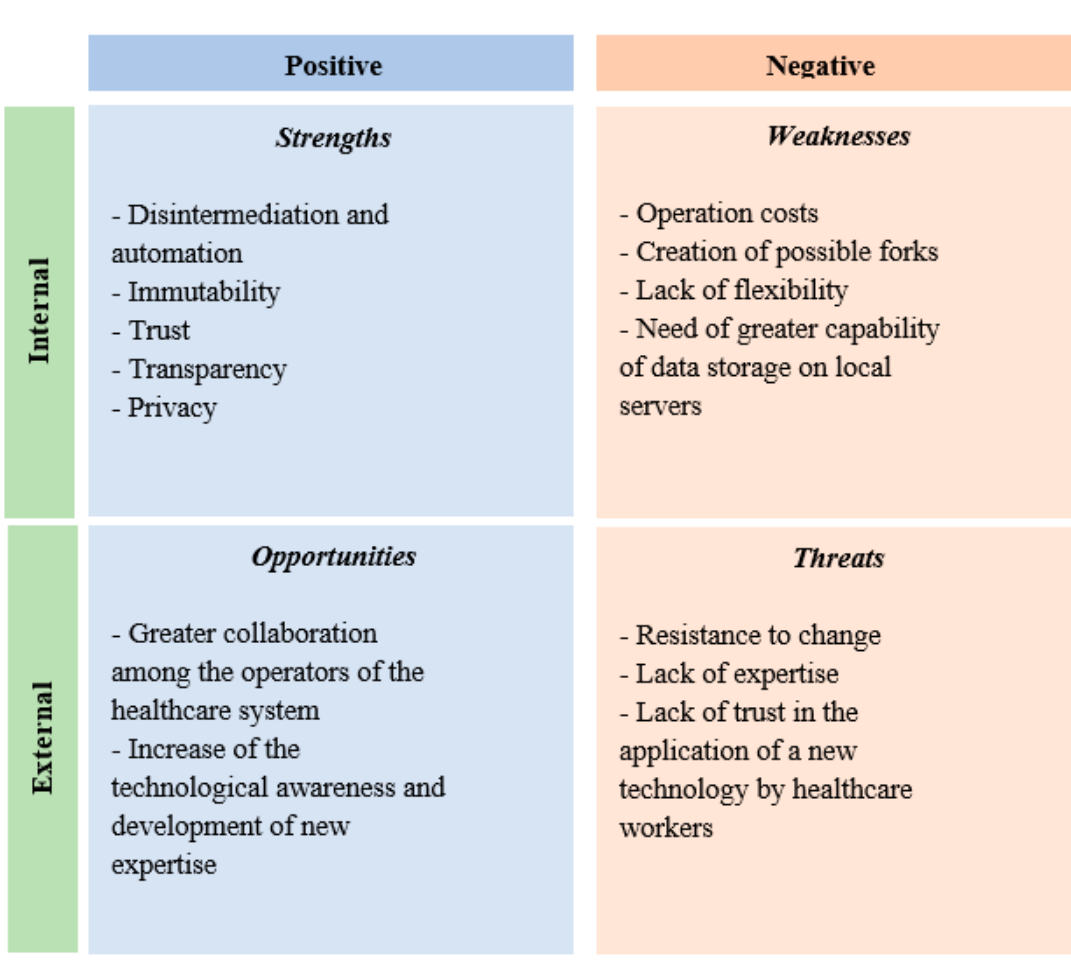
Figure 2. SWOT analysis of the adoption of the blockchain-based model in healthcare .